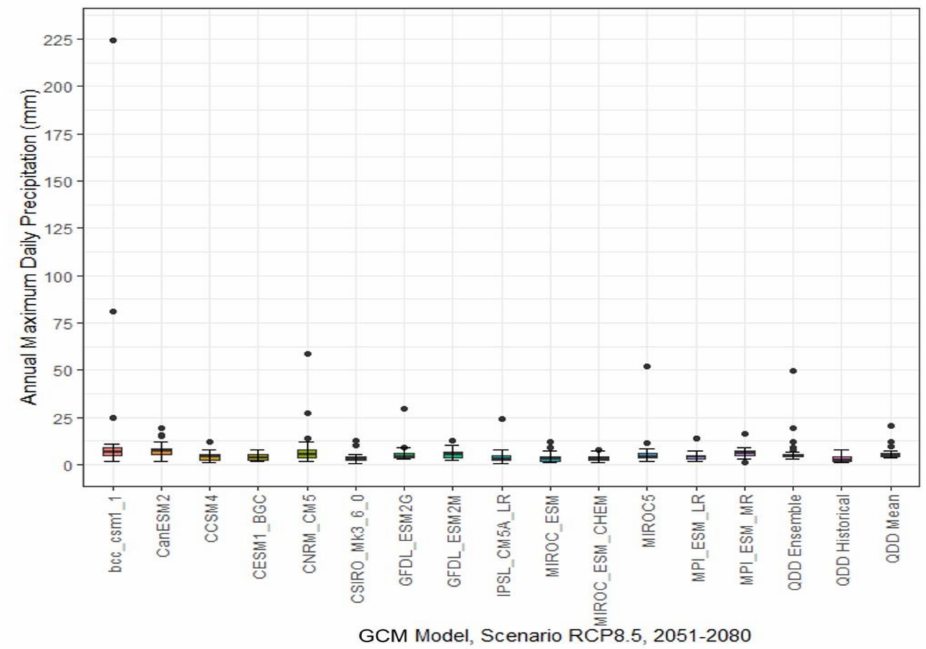
Figure 19. Boxplot for future projections of the annual maximum daily precipitation of 14 GCMs under the RCP8.5 scenario in the Devil’s Creek, 2051–2080 term. The linear extensions represent the highest and lowest values; the upper, middle, and lower limits of the box represent the percentiles of 75%, 50%, and 25%, respectively; and the solid circles represent the